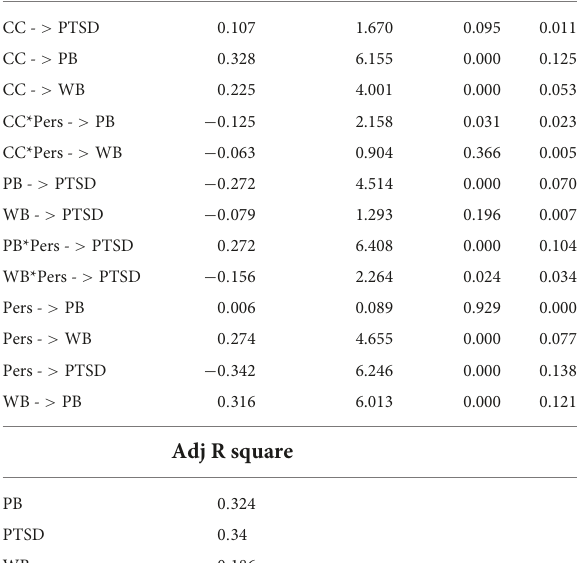
TABLE 4 Structural model statistics.